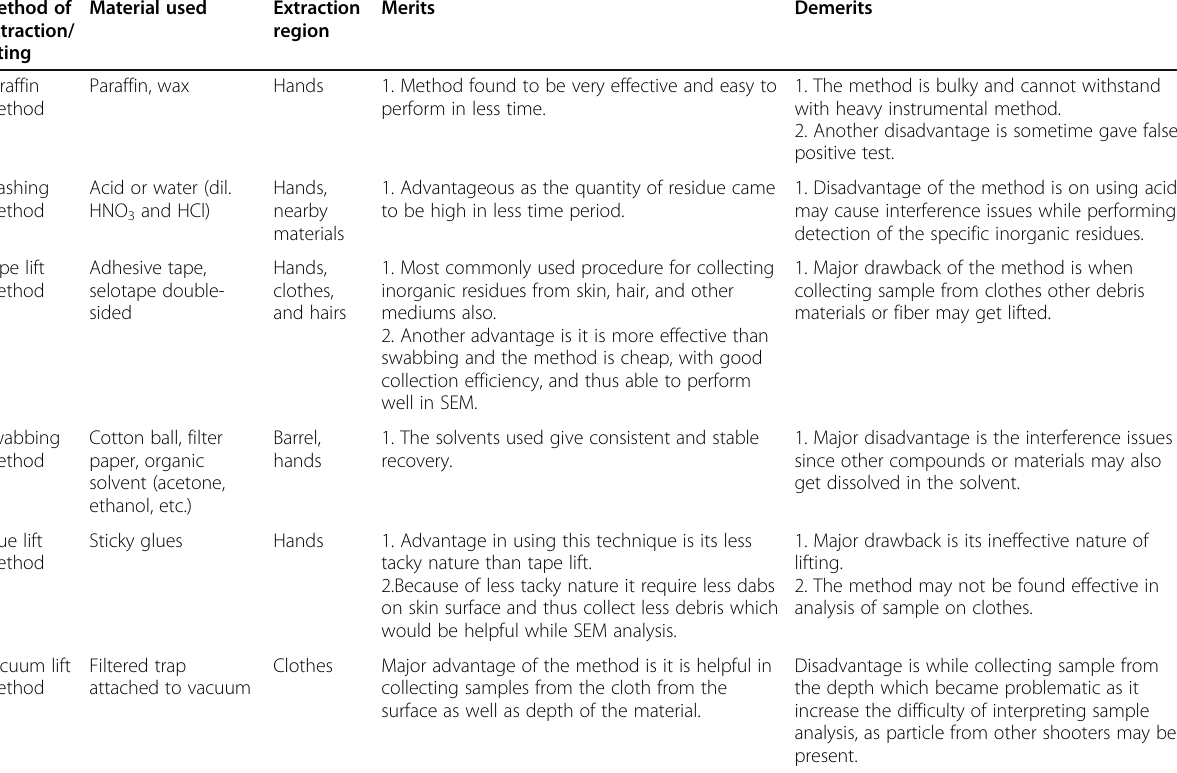
Glue lift method Here, sticky glues were poured over the sample, dried, and then lifted from the surface containing a huge amount of evidence. In comparison with tape lift, this method was found to be more effective as it is less sticky than tape. On analysis, the sample collected from the glue lift contains less interfering particles when SEM Table 2 Techniques applied to extract or lift the sample from different areas at the SOC Method of Material used Extraction Merits extraction/ region